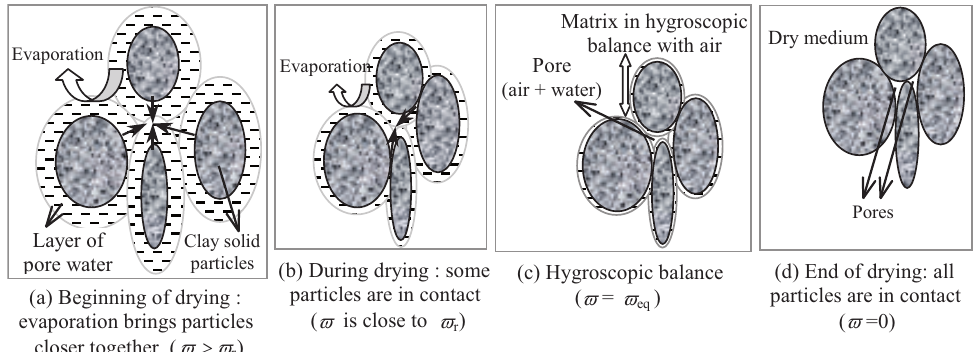
Fig. 6. Schematic representation of the shrinking mechanism in a clay matrix during drying.